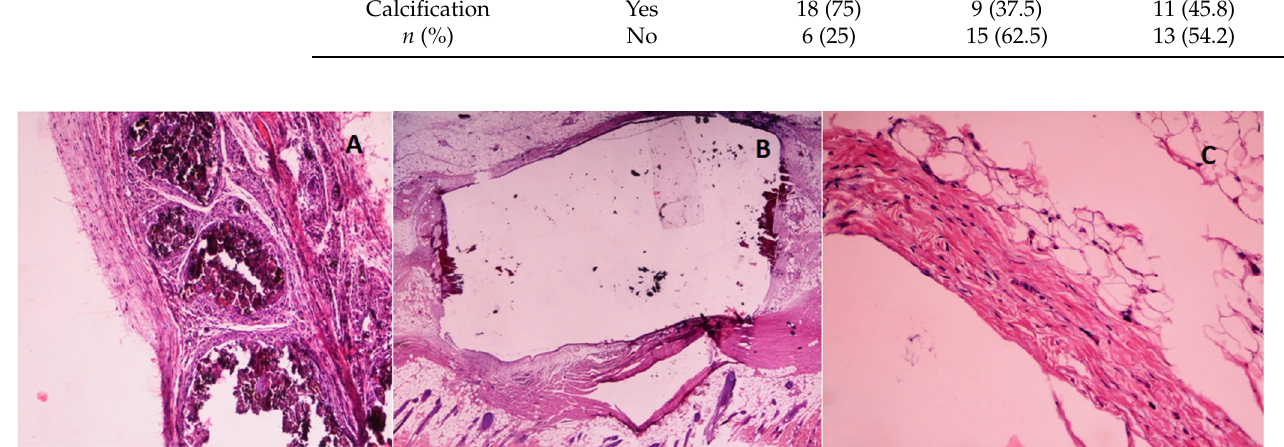
Figure 4. Hematoxylin–eosin stain. ( A ): Dystrophic calcification in the area of contact with MTA 30 days (200×). ( B ): Calcification on the open ends of the MTA-G3 polyethylene tube 30 days (40×). ( C ): 136 µm thick fibrous capsule Theracal 45 days (200×). Table 7. Presence of MTA, Theracal and MTA-G3 calcifications.